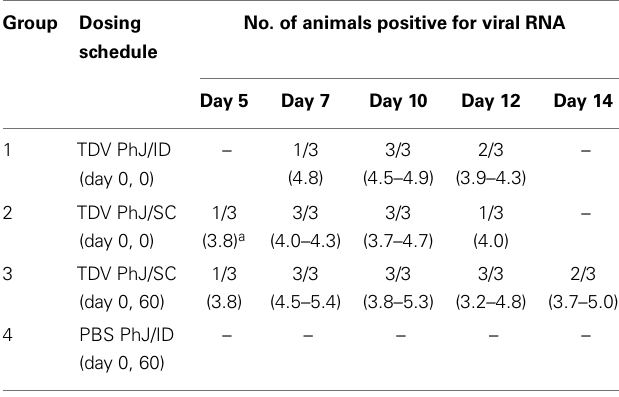
Table 3 |TDV-2 virus RNA detected in the serum after primary immunization withTDV .